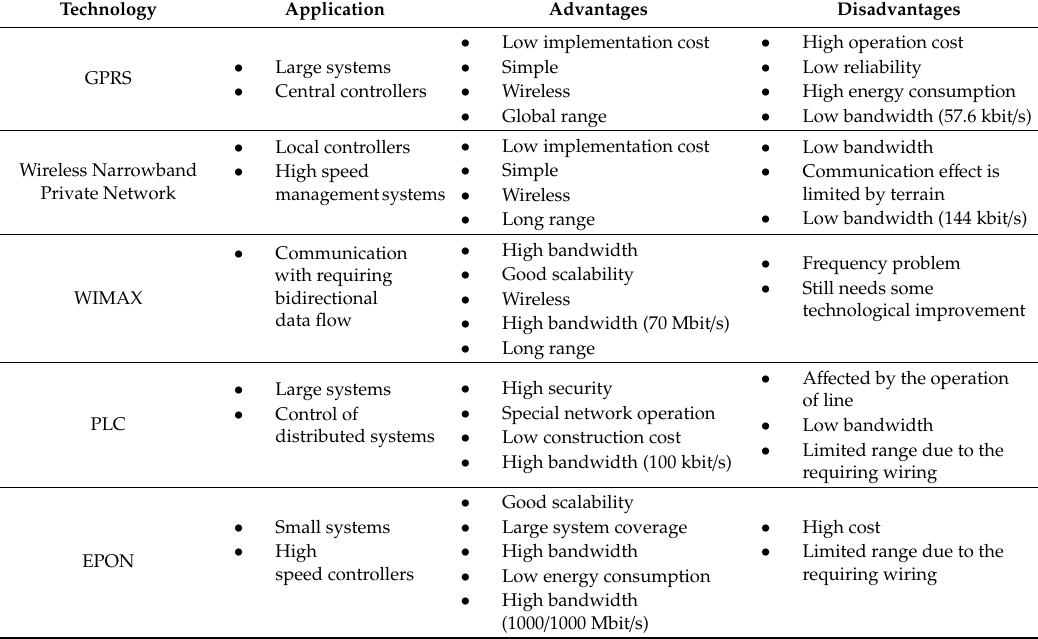
Table 3. Di ff erent network technologies. Abbreviations: GPRS; WIMAX, wireless broadband private network; PLC, power line communication; EPON, Ethernet passive optical network.